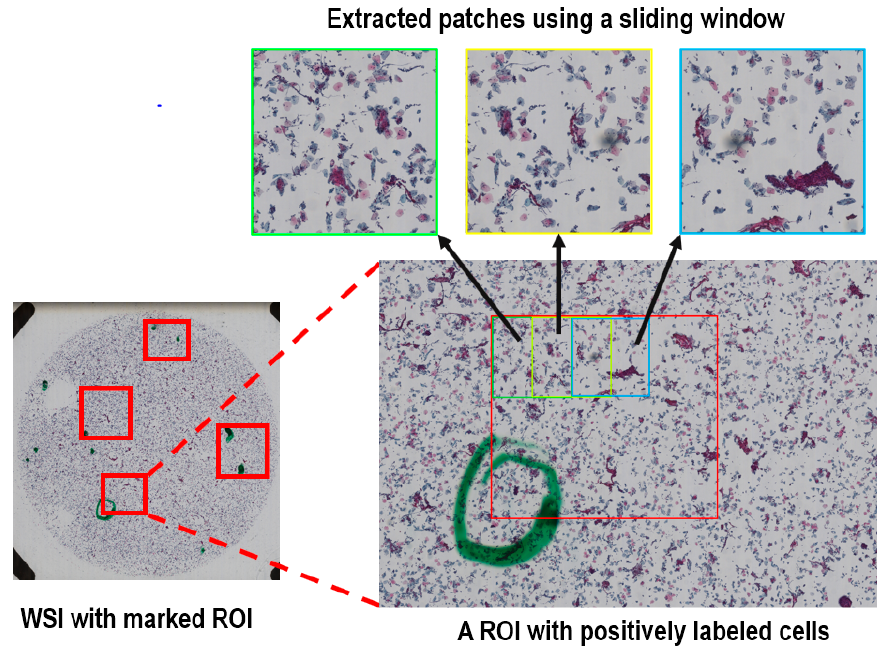
Figure 2. The preparation procedure for the positive WSIs to extract image patches of 2000 × 2000 out of the labeled ROIs using a sliding window with 50% overlap.